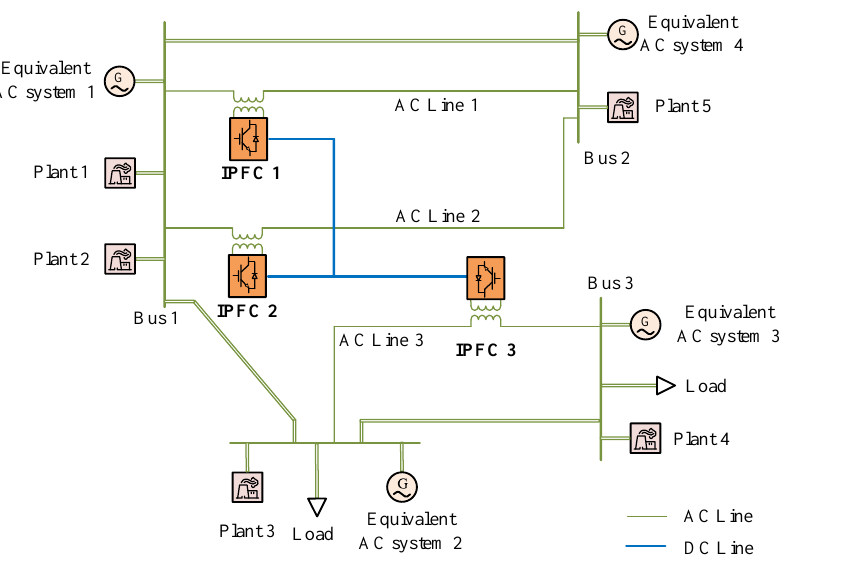
Figure 7. The test system with IPFC. Table 1. The Control Modes of Each IPFC